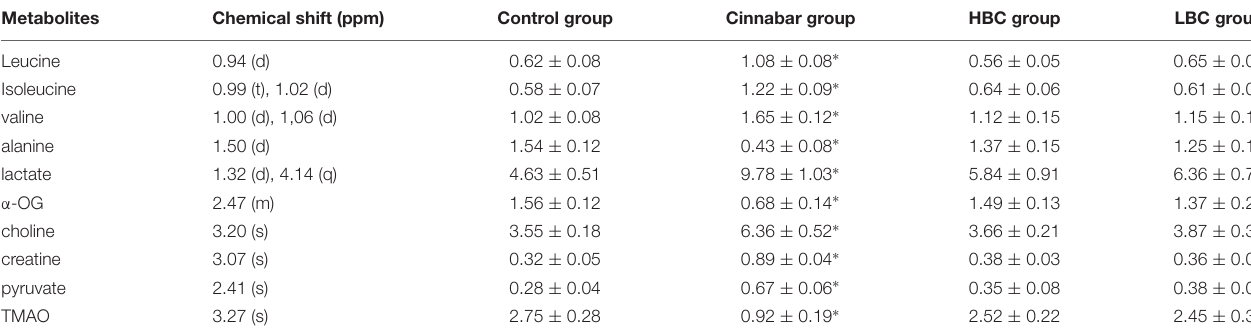
TABLE 3 | 1 H NMR-relative integral levels of metabolites in urine samples of groups control, cinnabar, HBC, LBC.